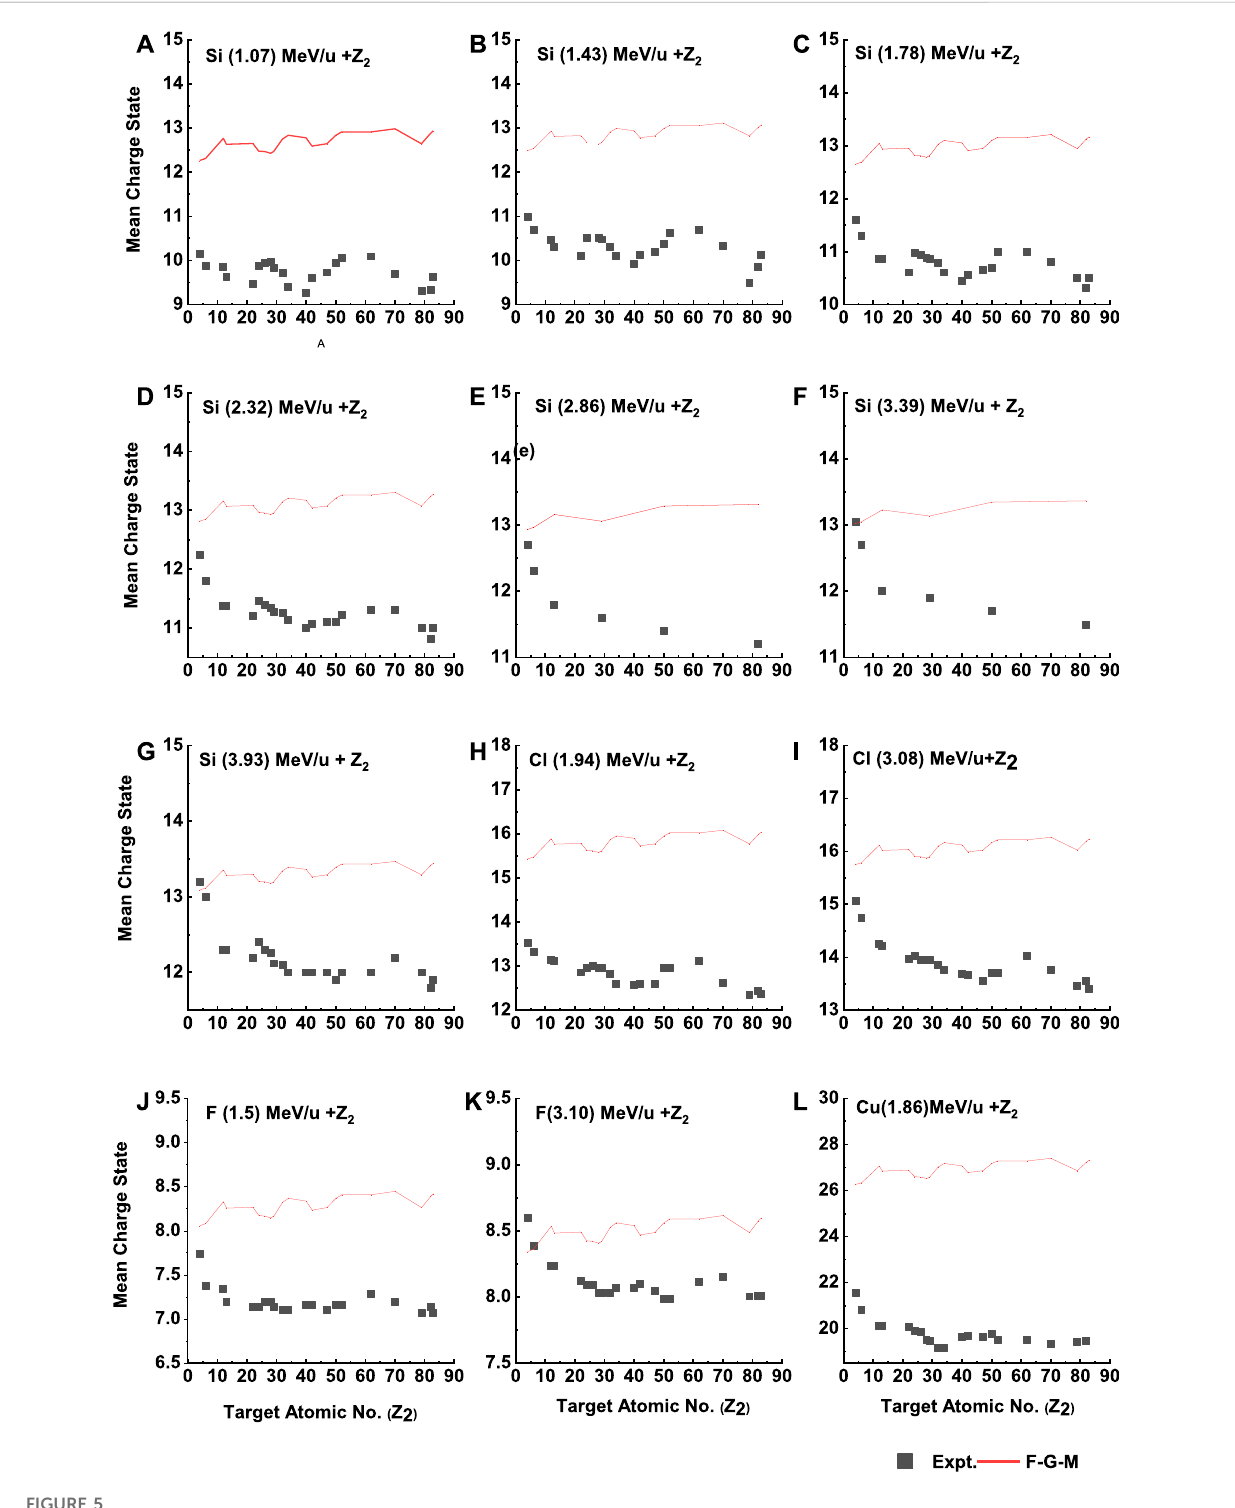
FIGURE 5 Comparison of experimental mean charge state (cid:1) q [26] with F-G-M mean charge state at different energies as a function of target atomic number (A-L) . The solid lines are to guide the eye only.